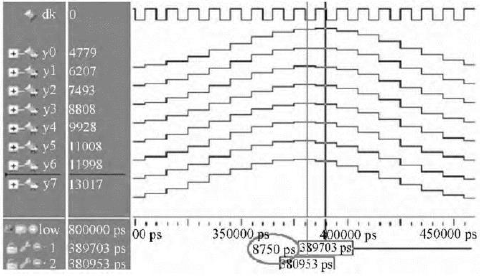
Figure 3. ModelSim simulation diagram of the multi-level half-band fine delay filter.